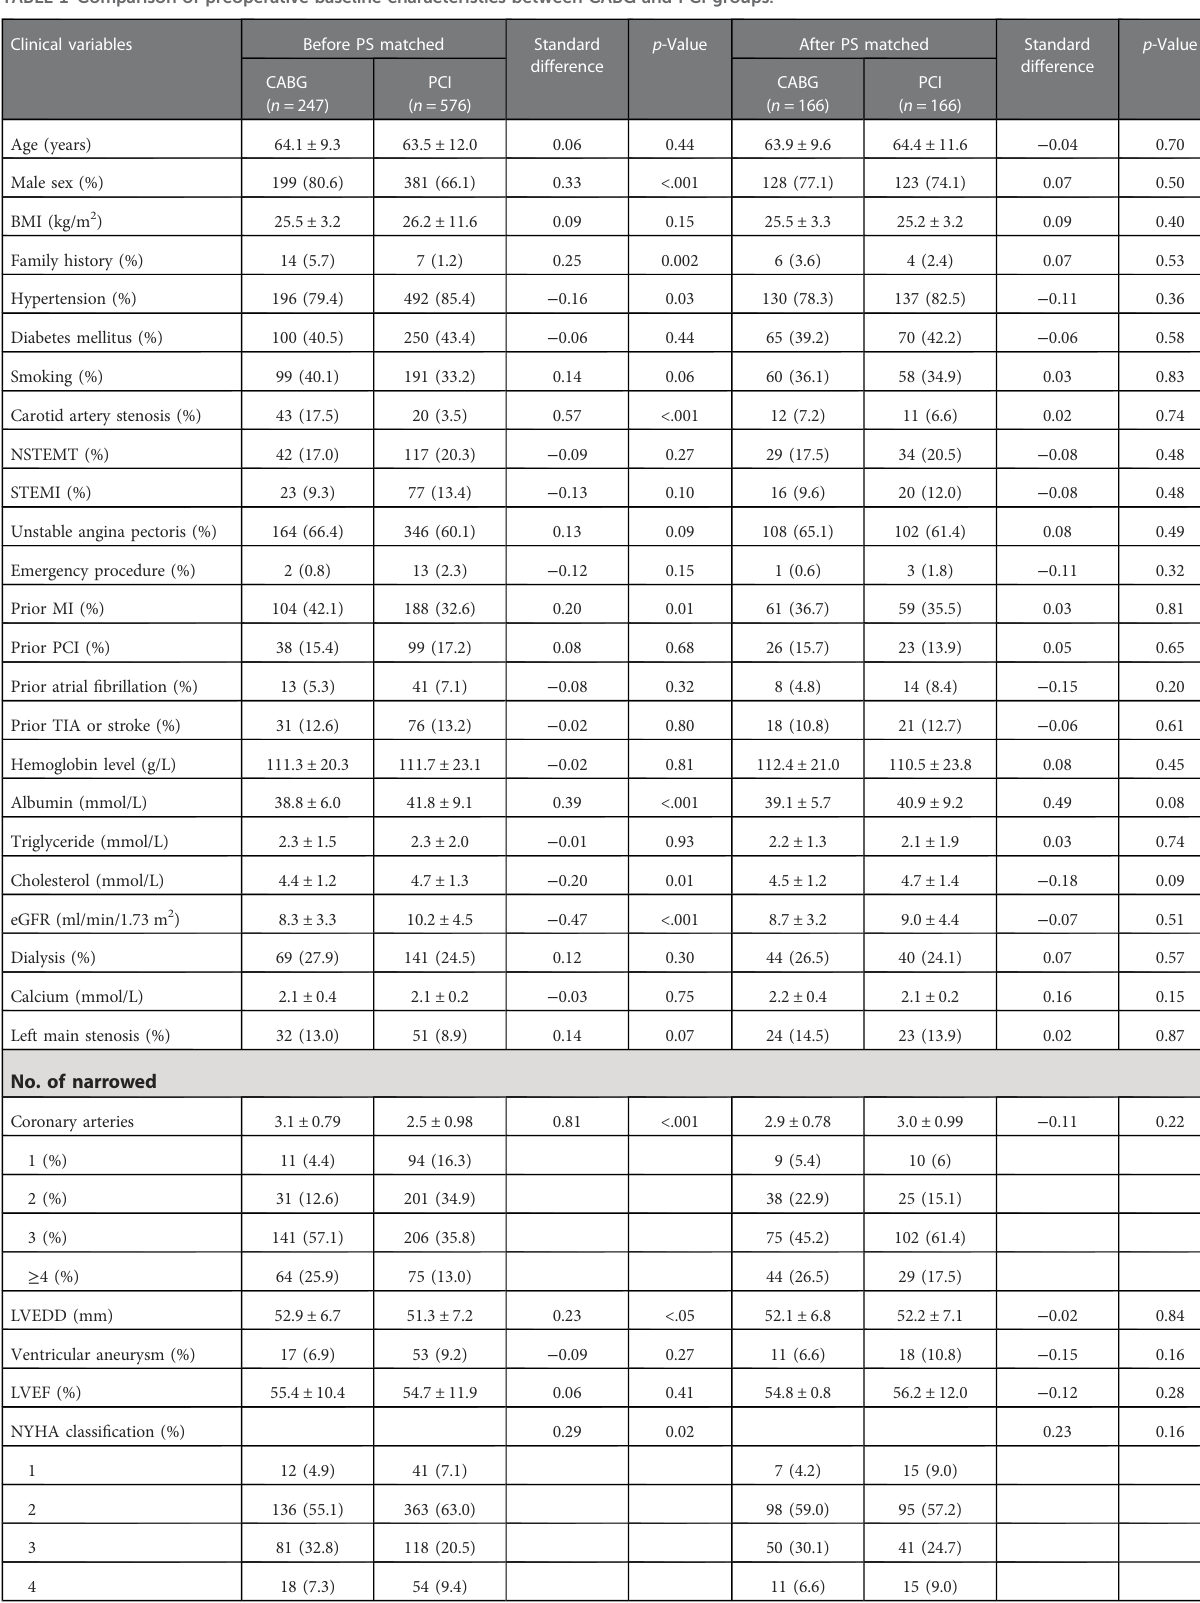
TABLE 1 Comparison of preoperative baseline characteristics between CABG and PCI groups. Clinical